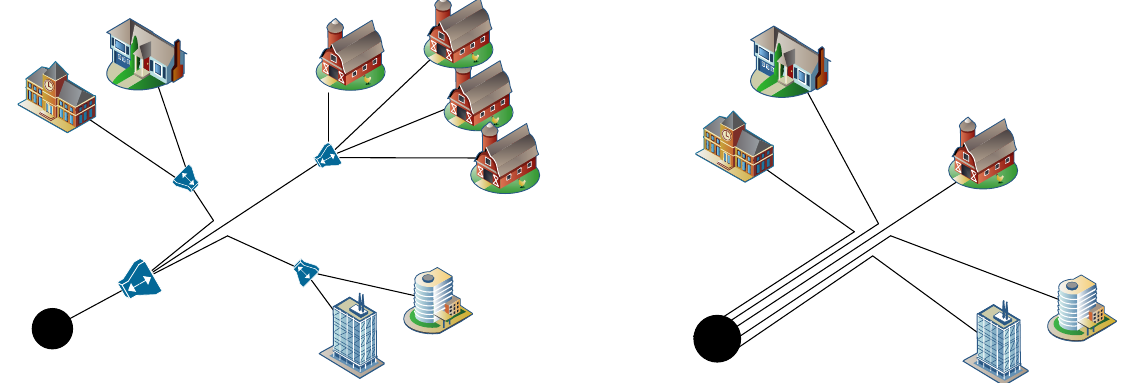
Figure 2. PON topology (point-to-multipoint (P2MP) scheme) and point-to-point (P2P) architecture on the right